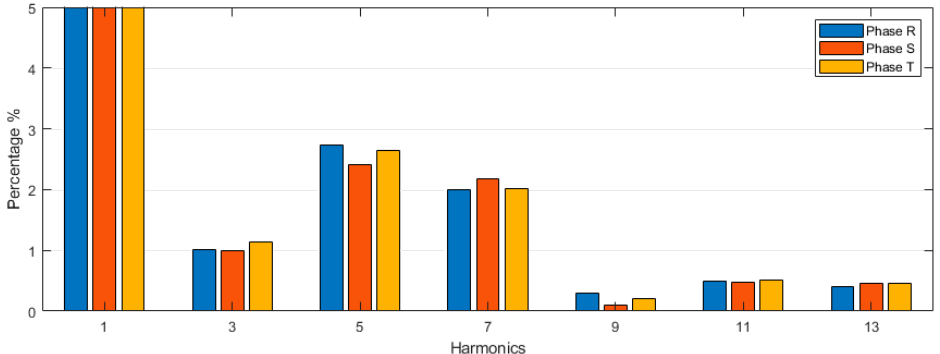
Figure 7. Current harmonics with a conventional charger.